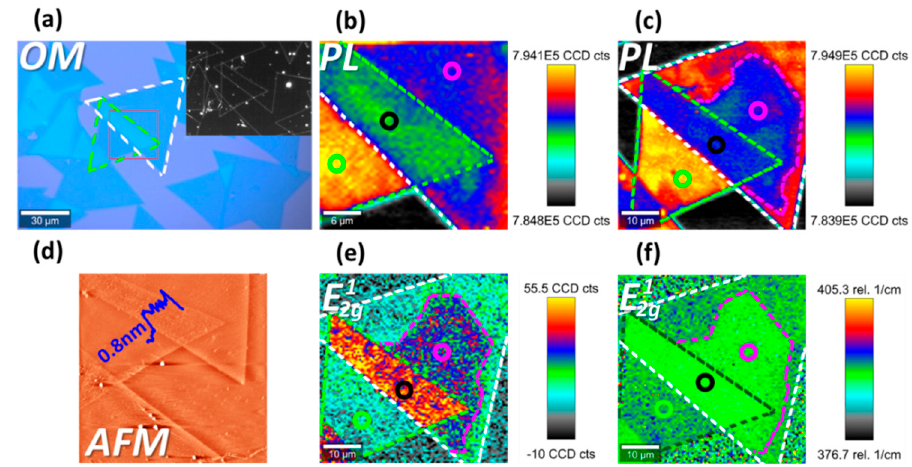
Figure 1. Interlayer difference of one twisted bilayer structure (tBLS) sample. Photoluminescence (PL) and Raman are all excited by 532 nm laser. ( a ) Optical micrograph. Inset corresponds to dark-field optical micrograph. The green and white dash lines outline the bottom and top layer respectively, while the red box outlines the scanning area in (b). ( b , c ) PL intensity map in high and low contrast respectively. ( d ) Atomic force microscopy (AFM) micrograph. ( e ) Raman intensity map of mode E 1 2g ( f ) Raman shift map of mode E 1 2g . Green, black, and magenta circles in (b–f) point out bottom, stacked, and top region respectively.